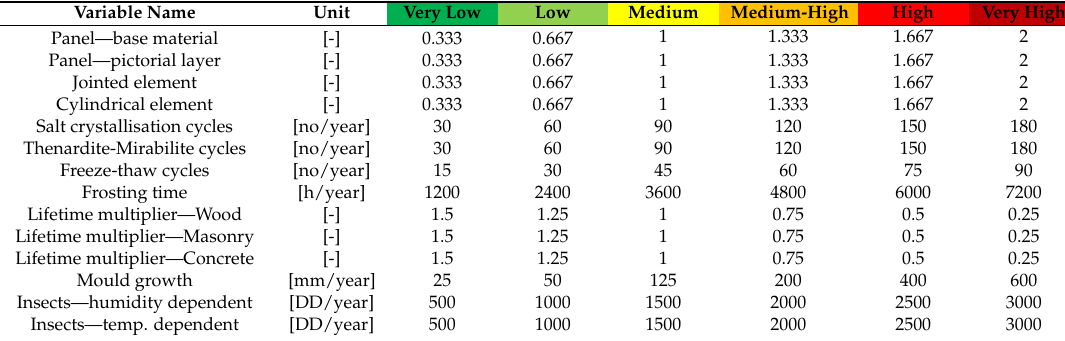
Table 5. The table of risk assessment for the main deterioration